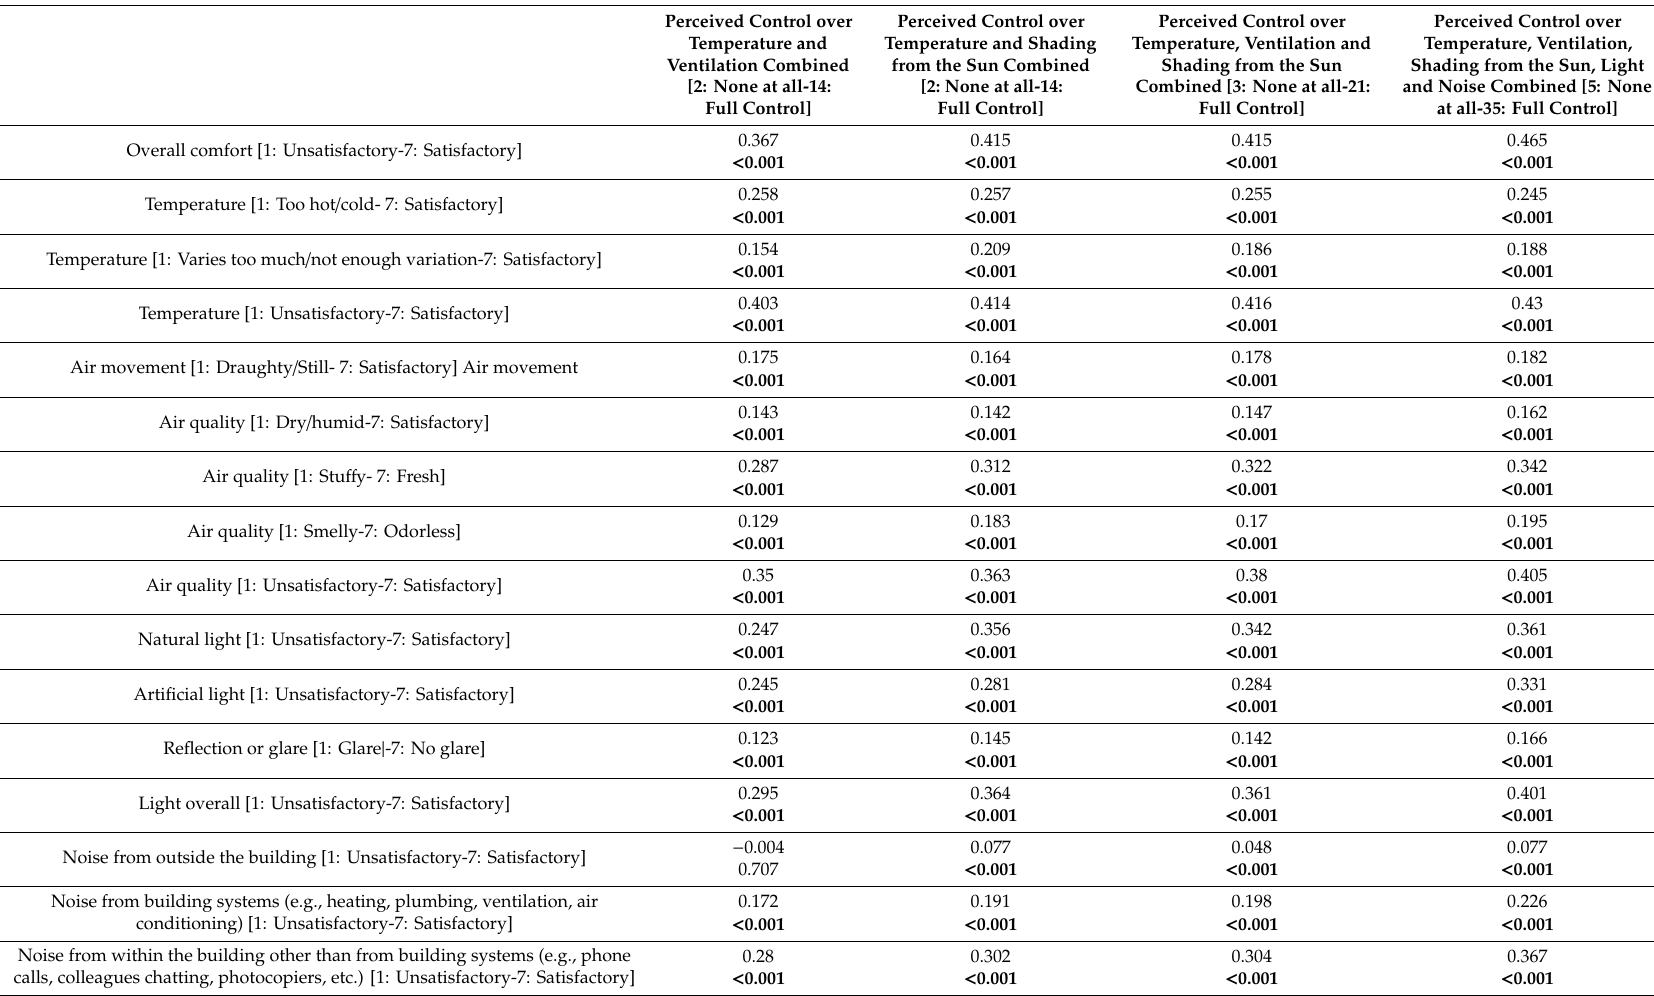
Table 6. Correlations between combined perceived control and perceived comfort and